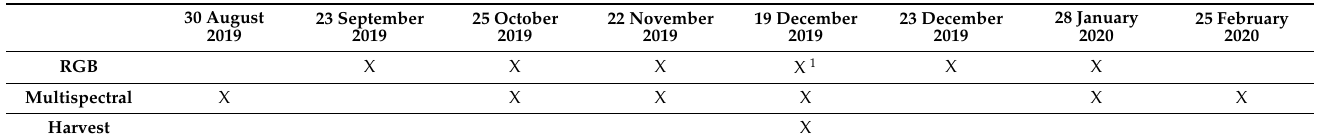
Figure 2. SfM mission settings selected in a flight planning application ( a ). Flight parameters and path were maintained across all RGB data collection campaigns (Table 1). The application does not provide a quantitative specification for flight speed as this setting is largely dependent on image overlap. Unlike the low-altitude, automated missions executed for collecting SfM data, the use of a third-party multispectral camera prevented mission automation. Multispectral images were collected at much higher altitudes (e.g., 100 m AGL) with manual operation of the UAS ( b ). For this reason, no two multispectral imaging missions conducted across time were identical. However, full-field coverage, reduced image blur, and nadir camera pitch were prioritized. Table 1. Date and type of data